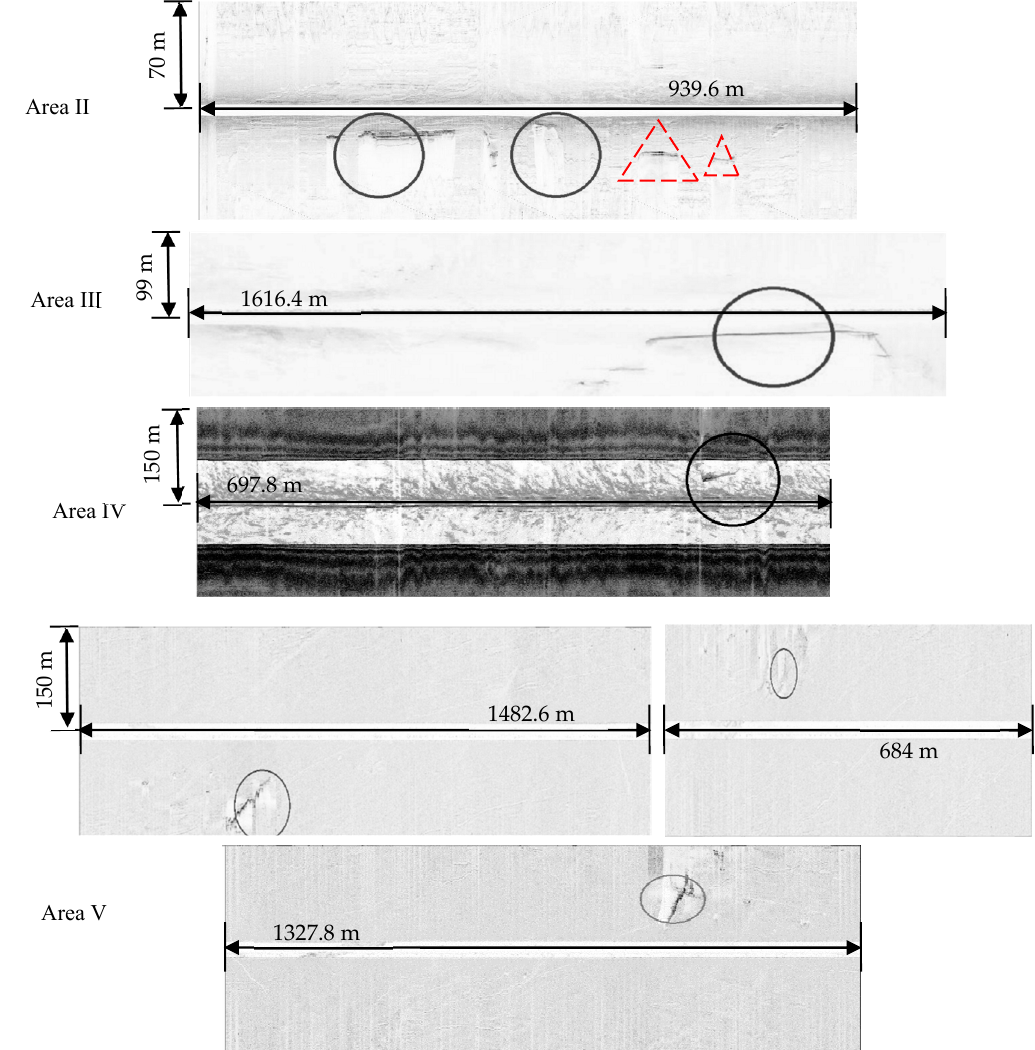
Figure 10. The shipwreck target recognition results in other surveying areas.